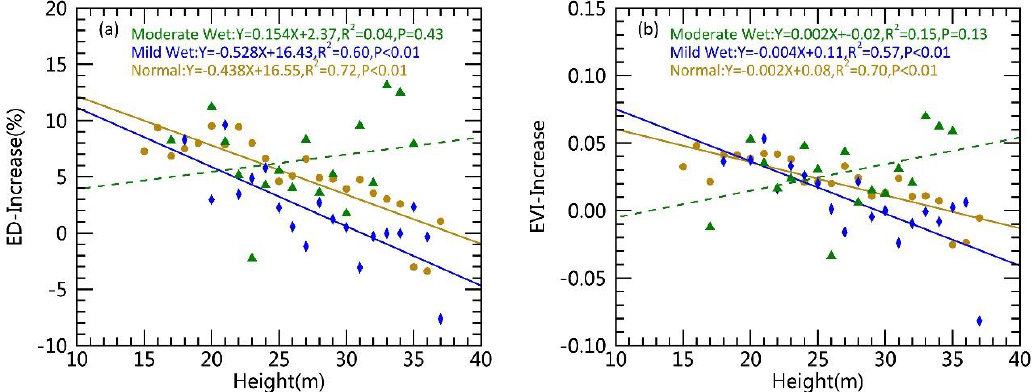
Figure 5. Linear regressions between the increase of EVI Deficit (ED) (from 2012 to 2014) and canopy height ( a ), and between enhanced vegetation index (EVI) (from 2012 to 2014) and canopy height ( b ) under three different water conditions (Normal: −0.5 < SPEI ≤ 0.5; Mild Wet: 0.5 < SPEI ≤ 1; Moderate Wet: 1 < SPEI ≤ 1.5). The effects of canopy heights on forest recovery were no longer significant for the moderately wet condition.